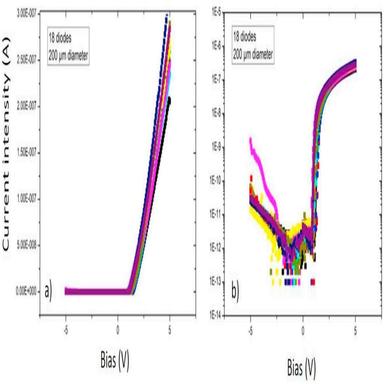
I-V characteristics of 18 diodes of 200 μm diameter at RT and under vacuum a) in linear scale; b) in logarithmic scale.